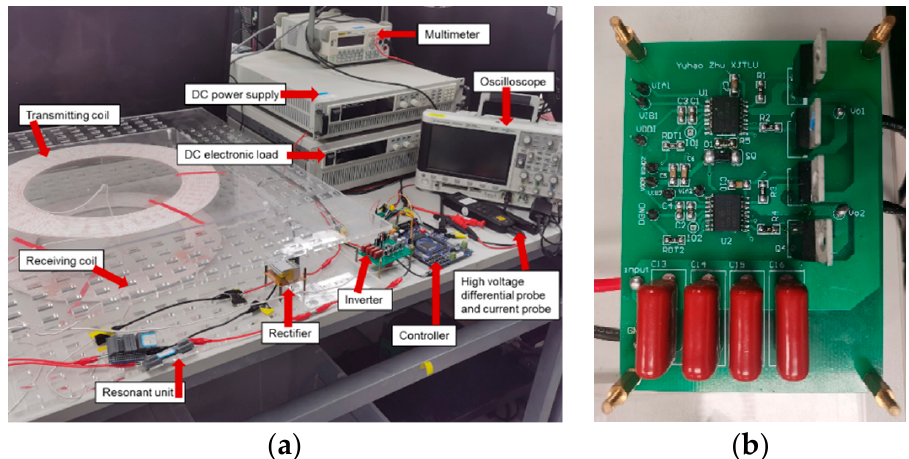
Figure 5. ( a ) Experimental platform of proposed WPT system, ( b ) Cascade GaN based high frequency full bridge inverter. Table 1. Parameters of S-S and LCCL-S resonant compensation.